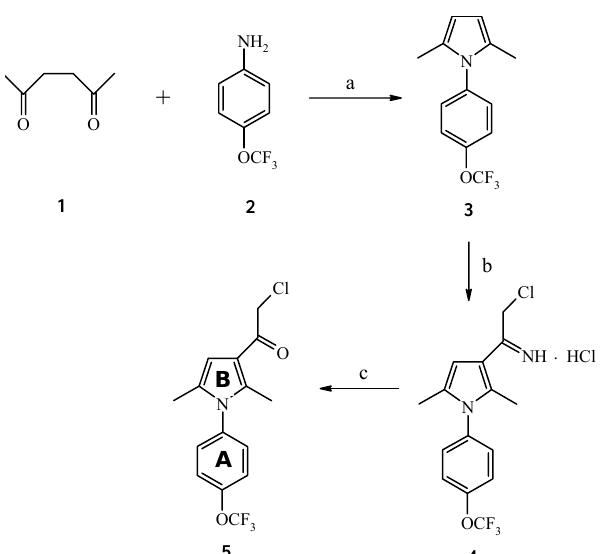
Scheme 1. Synthesis of 3-chloroacetylpyrrole ( 5